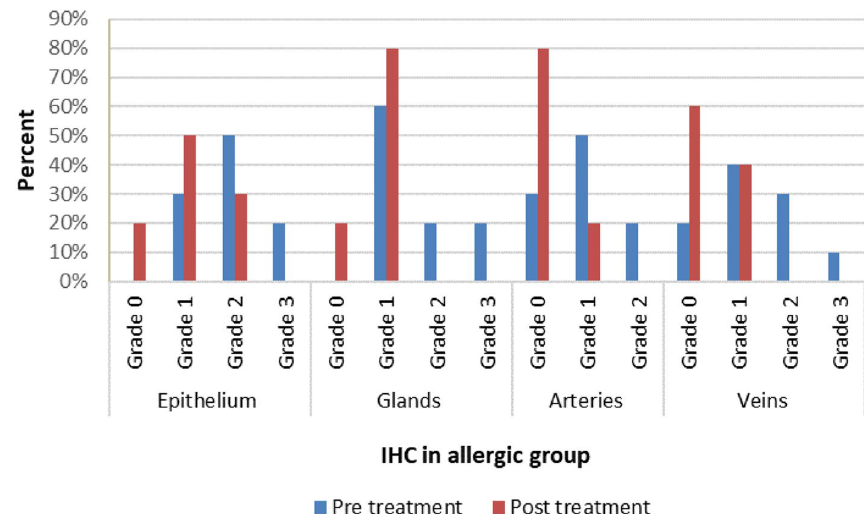
Fig. 4 Comparison between the pre- and post-IHC data among allergic cases study groups